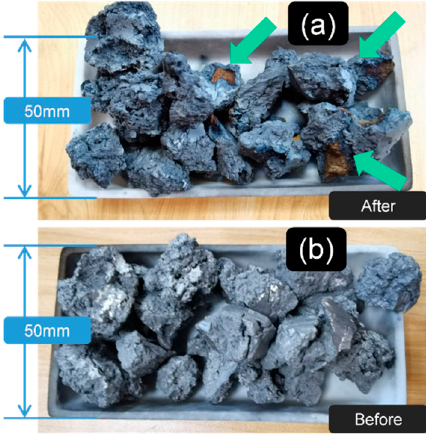
Figure 2. The morphology of the fed sponge titanium showed that the oxygen-absorbed metal could be polluted with the typical oxidation color even in the high vacuum environment; the result also indicated that it was necessary to add the sponge titanium in the heat-treated process: ( a ) the sintered state; and ( b ) the original state.